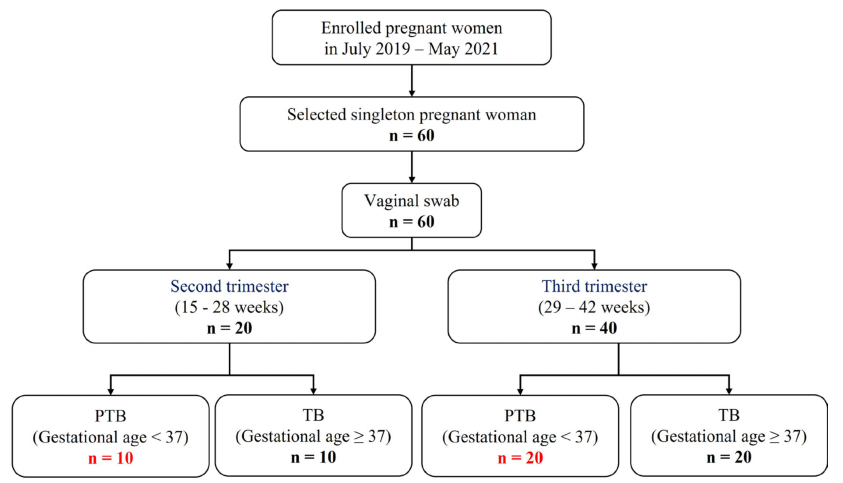
Figure 1. Flow chart of study